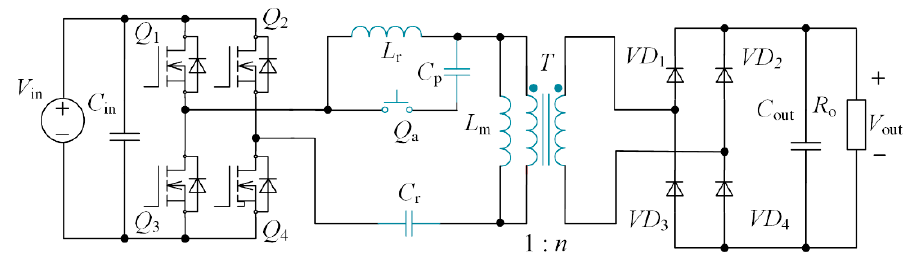
Figure 7. The topology of the proposed converter.